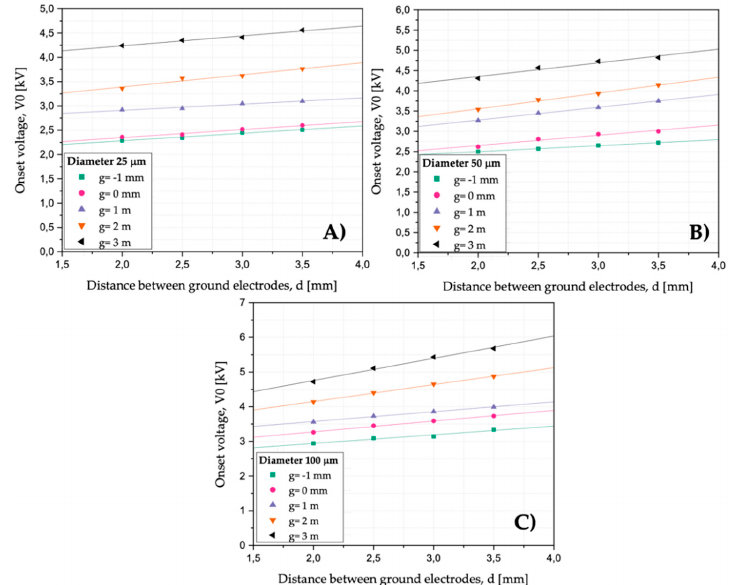
Figure 7. Variation in the initial voltage V 0 according to D and g for different wire diameters of ( A ) 25, ( B ) 50, and ( C ) 100 μ m.